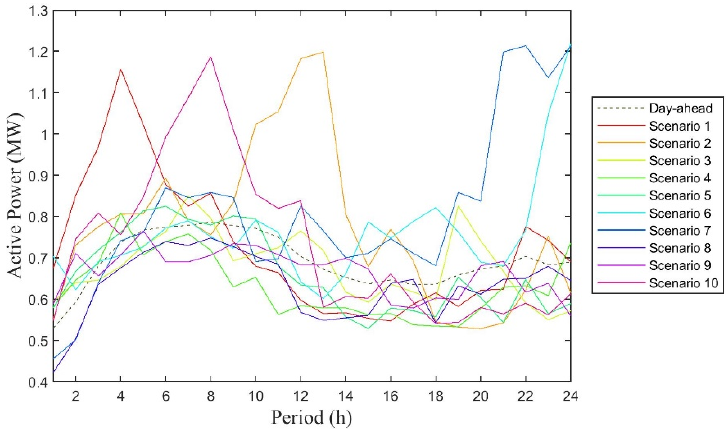
Figure 3. Point forecast and scenarios of the wind power plant 1 throughout 24 hours.